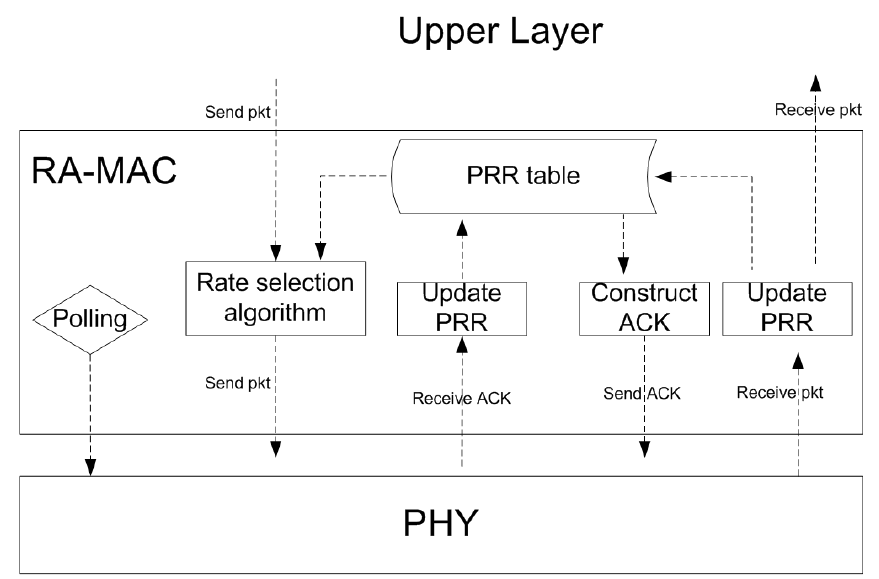
Figure 3 . RA-MAC components in